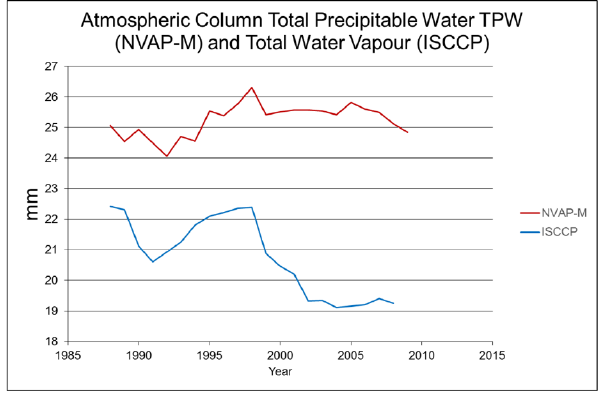
Figure 9. Estimates of global annual average atmospheric total precipitable water and total water vapor.